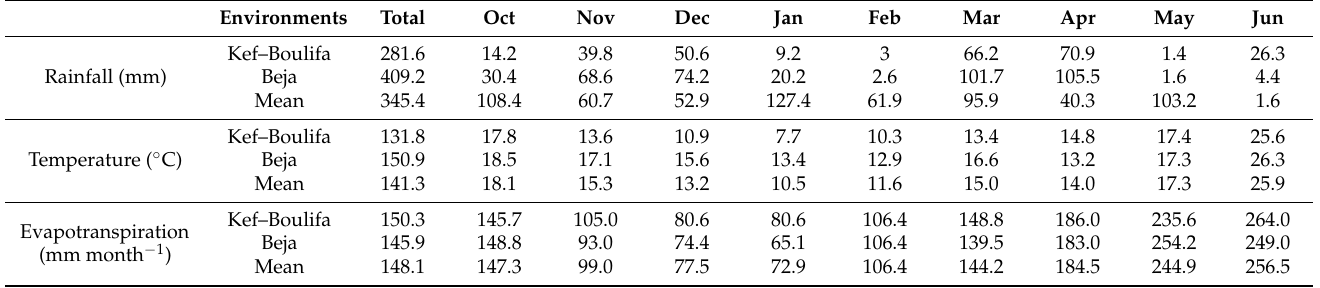
Table 6. Climatic variations in Kef–Boulifa and Beja sites during 2019/20 cropping